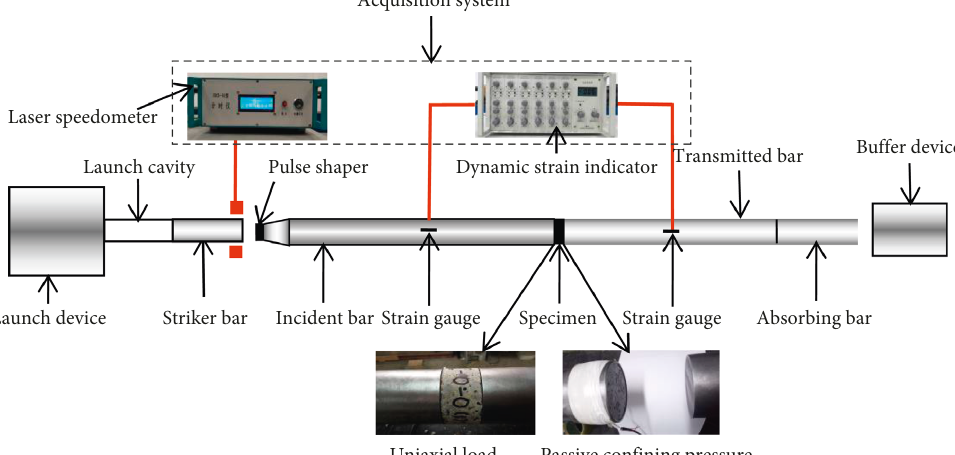
Figure 2: SHPB test apparatus of ready-mixed concrete specimens.